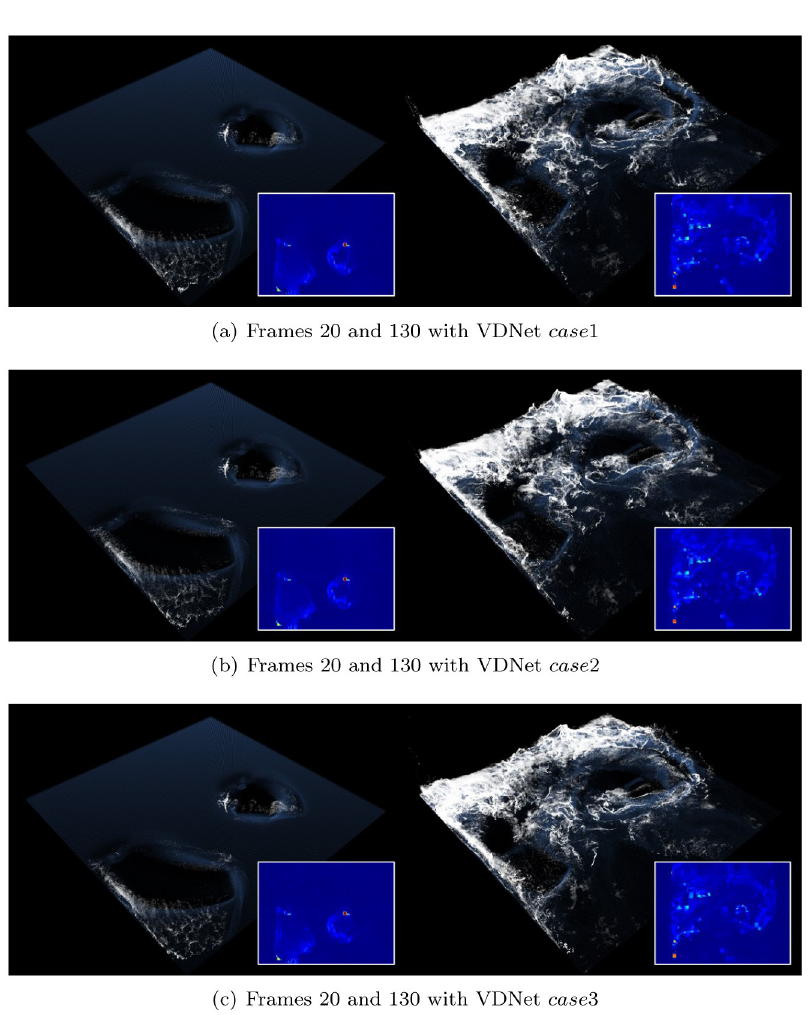
Fig 20. Foam effects with previous method and same scene as Fig 13 (inset image: Refined acceleration map with VDNet [67]). (a) Frames 20 and 130 with VDNet case1, (b) Frames 20 and 130 with VDNet case2, (c) Frames 20 and 130 with VDNet